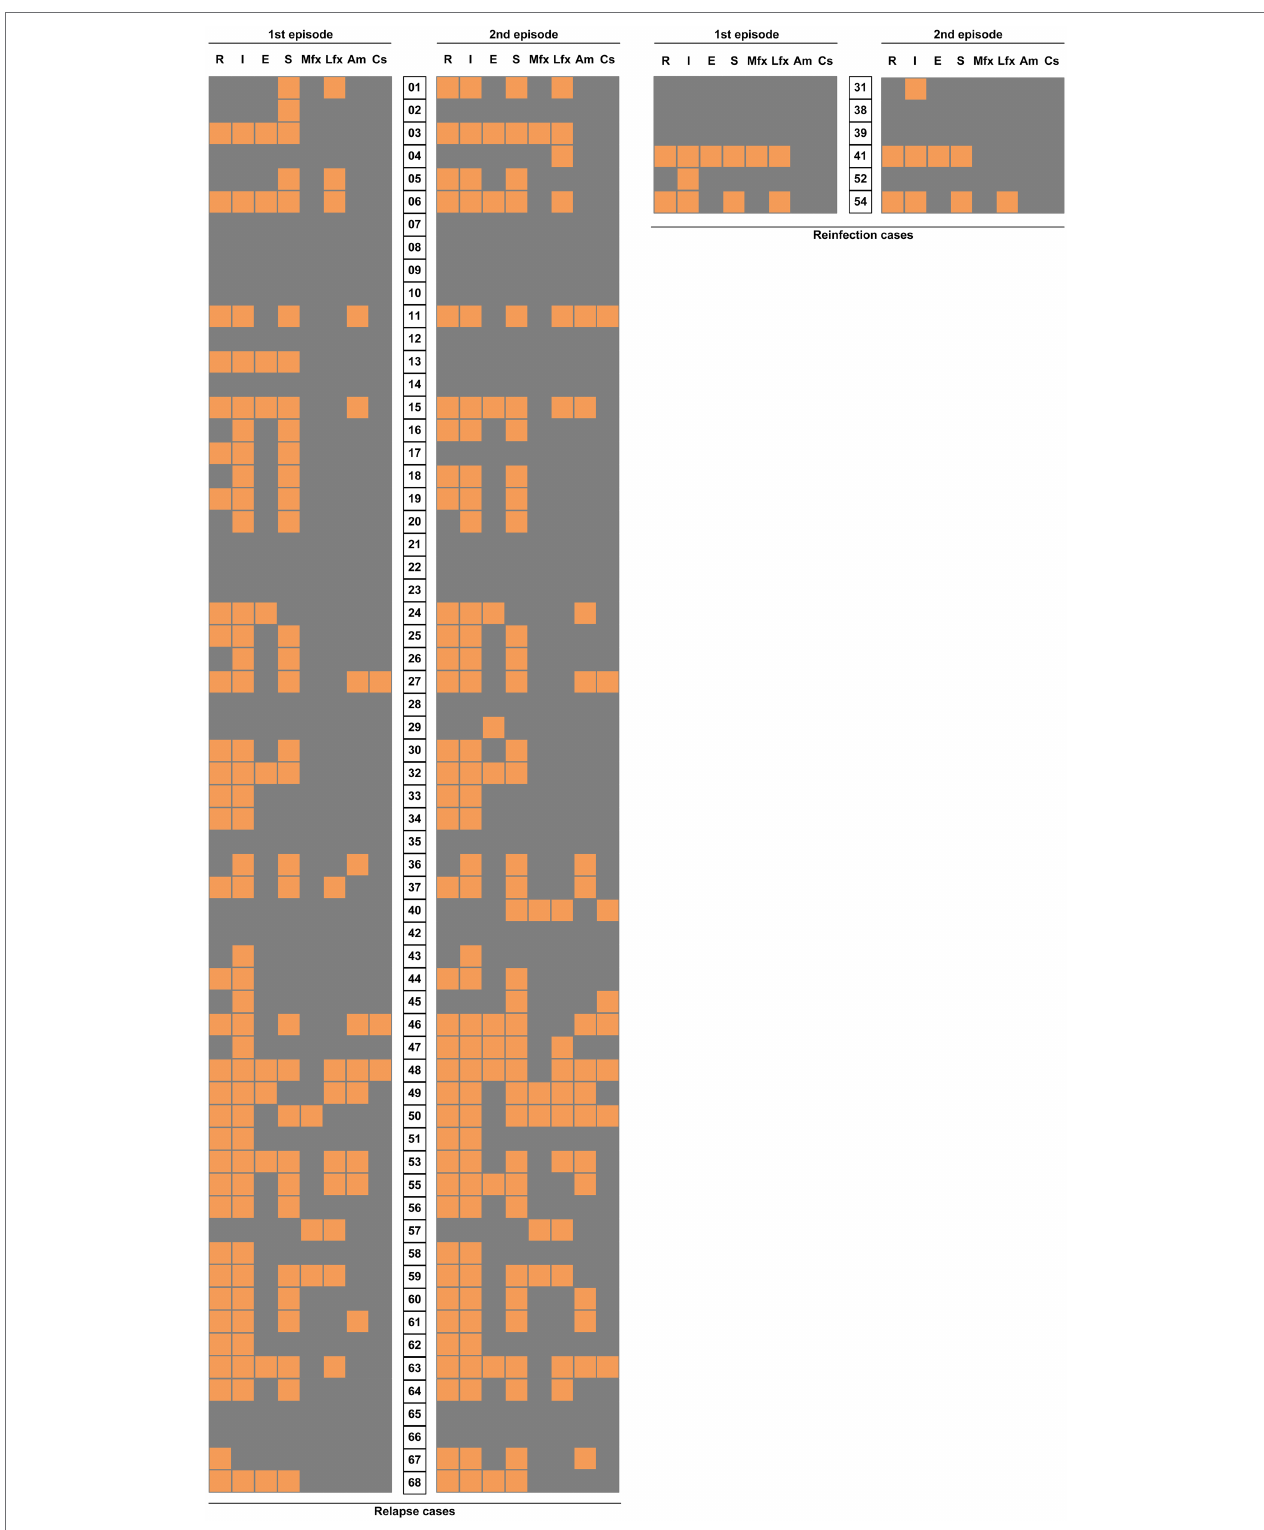
FIGURE 7 | Comparison of drug sensitivity distribution between the two TB episodes. Each grid represents the result of drug susceptibility test with isolates from two episodes of each patient. The results are shown in an orange-gray color scale, where orange represents resistance to the corresponding drug and gray represents susceptivity to the corresponding drug. R, rifampicin; I, isoniazid; E, ethambutol; S, streptomycin; Mfx, moxifloxacin; Lfx, levofloxacin; Am, amikacin; and Cs,